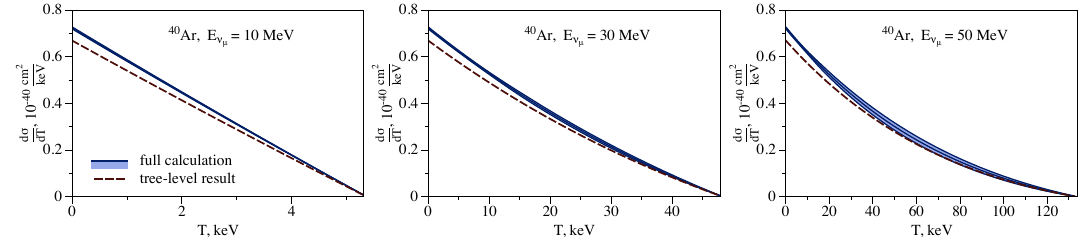
Figure 3 . CE ν µ NS cross section on 40 Ar target (blue band) compared to the tree-level prediction (red dashed curve) as a function of the recoil nucleus energy for the incoming neutrino energies = 10 , 30 , and 50 MeV . The error bands shown here include the full error budget outlined E ν µ in section 2.4 and summarized in table